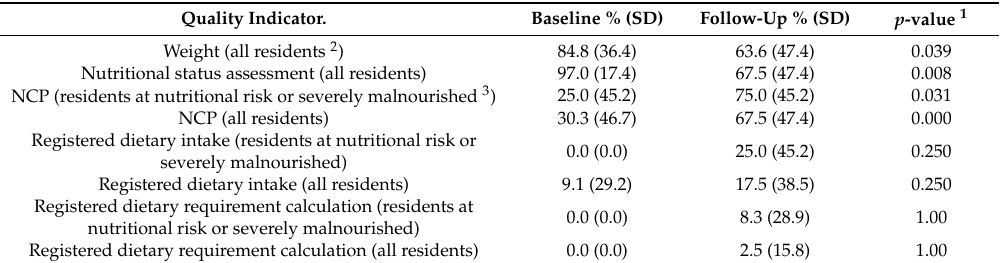
Table 4. Quality indicators for nutritional care developed by the Norwegian Directorate of Health [10]. The proportion (%) and standard deviation (SD) at baseline and follow-up are given. Quality